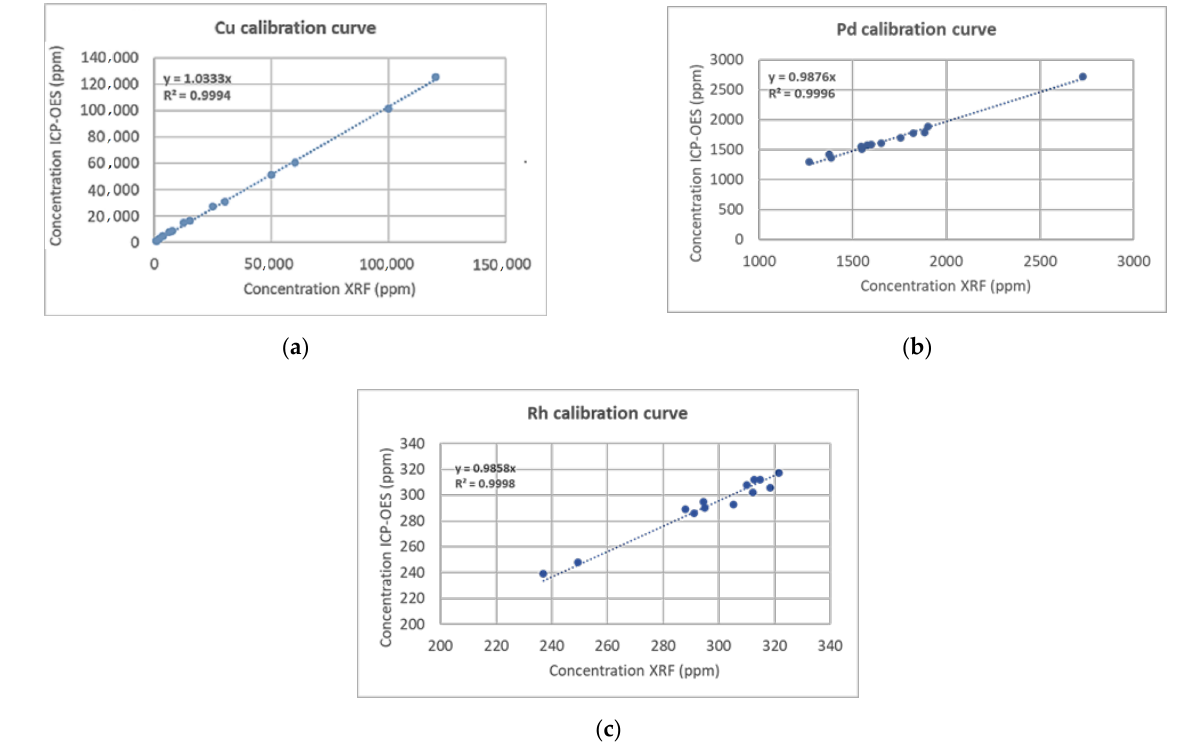
Figure 14. Calibration curves for: ( a ) Cu in the loading range 0.7–12%; ( b ) Pd in the loading range < 1270–2730 ppm; ( c ) Rh in the loading range 230–330 ppm.